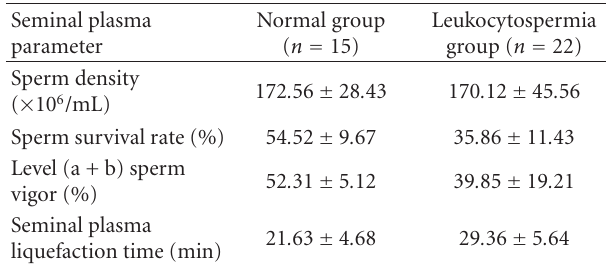
Table 2: Comparison of TNF- α and PAF concentration between leukocytospermia group and normal group.